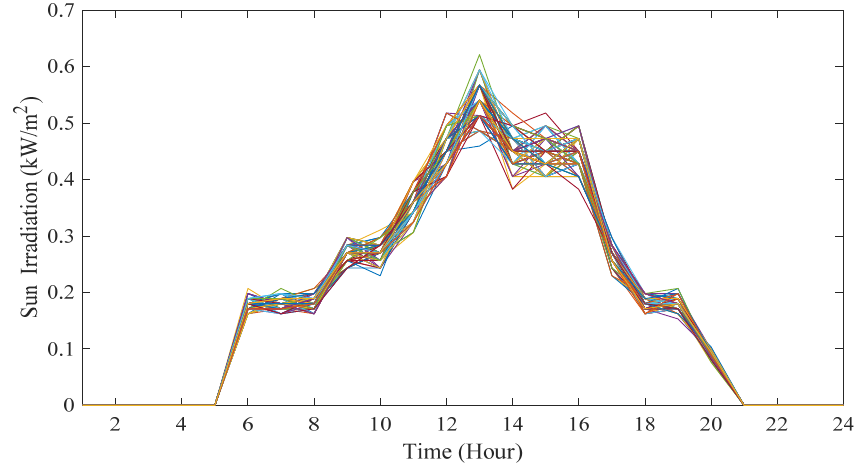
Figure 11. Heat demand prediction using LSTM.